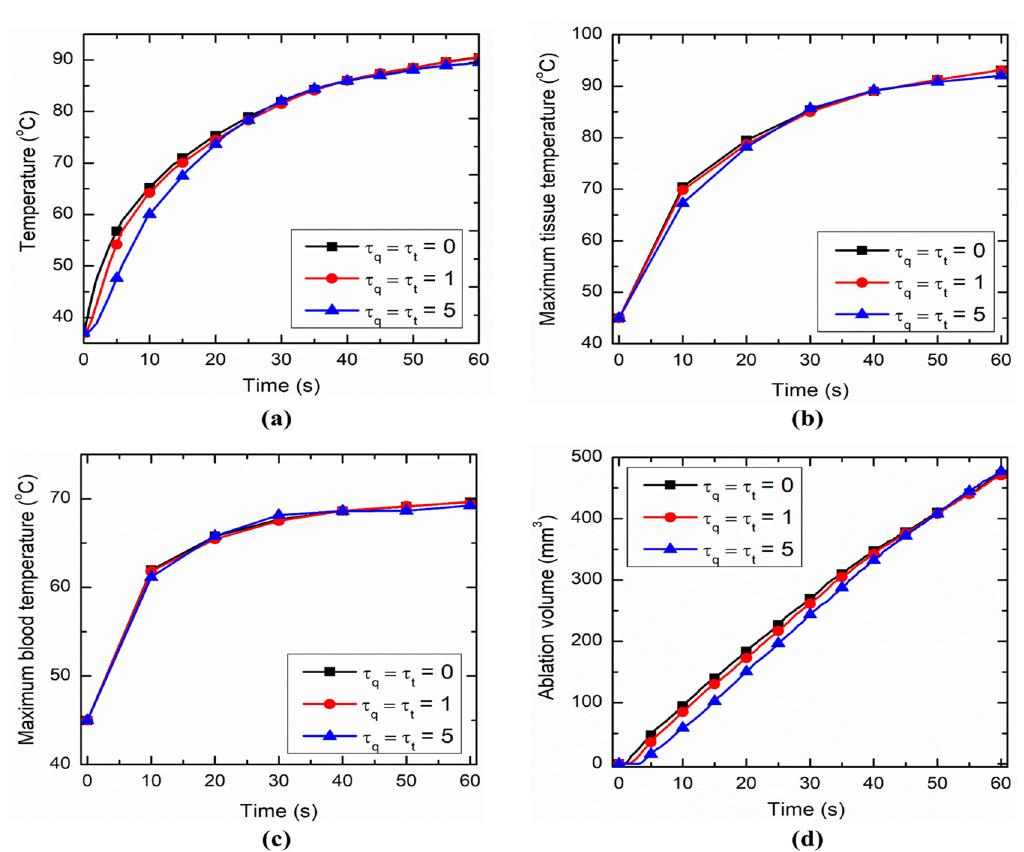
Figure 4. Temporal variation of: ( a ) temperature at a point 1 mm away from tip of electrode, ( b ) maximum tissue temperature, ( c ) maximum blood temperature, and ( d ) ablation volume for different values of thermal relaxation times.